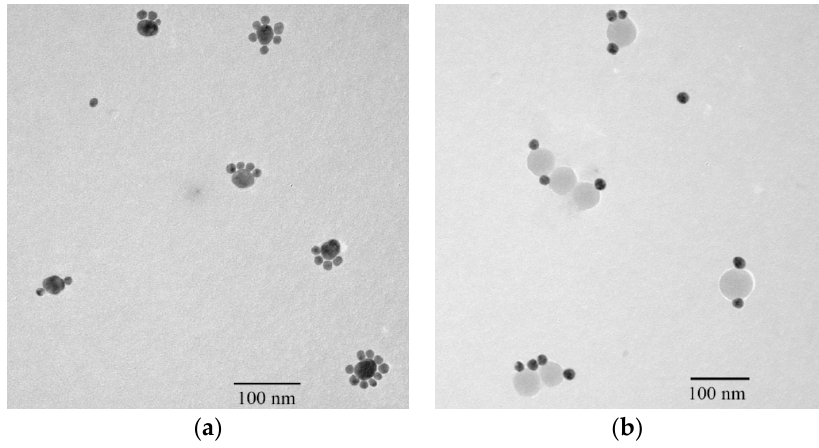
Figure 5. Nanostructures of ( a ) Au nanoparticles (AuNPs) self-assemblies and ( b ) fluorescent DNA probes by the traditional